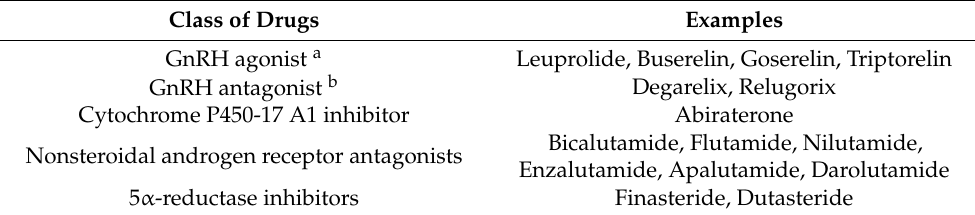
Figure 1. Mechanism of action of antiandrogen therapy GnRH = gonadotropin releasing hormone receptor agonist; LH = luteinizing hormone; LH-RH= luteinizing hormone releasing hormone; GnRH-R = gonadotropin releasing hormone receptor; GnRH antagonist = gonadotropin releasing hormone antagonist; LH-R = luteinizing hormone receptor on testis; NARA = nonsteroidal androgen receptor antagonis; DHT = dihidrotestosterone, CYP 17A1 = cytochrome P450 17 A1; 5–10% of testosterone is transformed by 5- α reductase in the more potent DHT, 0.2% testosterone is transformed by aromatases in 17 β -estradiol and the rest of testosterone is inactivated by the liver; GnRH agonists provoke an increase of LH in the first weeks of treatment but finally down regulate LH secretion from the anterior pituitary gland. GnRH antagonists block the GnRH receptors on the anterior pituitary gland thus decreasing the synthesis of LH and FSH. NARA block the activation of the androgen receptor from the prostate cells and augment the effectiveness of GnRH agonists or antagonists, CYP 17 A1 inhibitors decrease the synthesis of testosterone from cholesterol. Table 1. Class of hormonal drugs used in advanced prostate